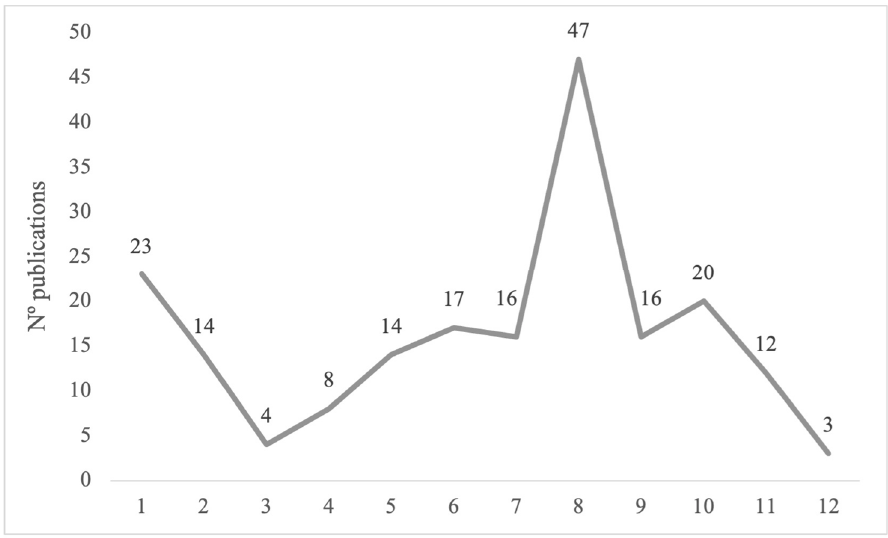
Figure 1. Twi tt er publications by Vox (@vox_es) on Islam and/or Muslims during 2022. Source: pre- pared by the author based on data provided by the Twi tt er